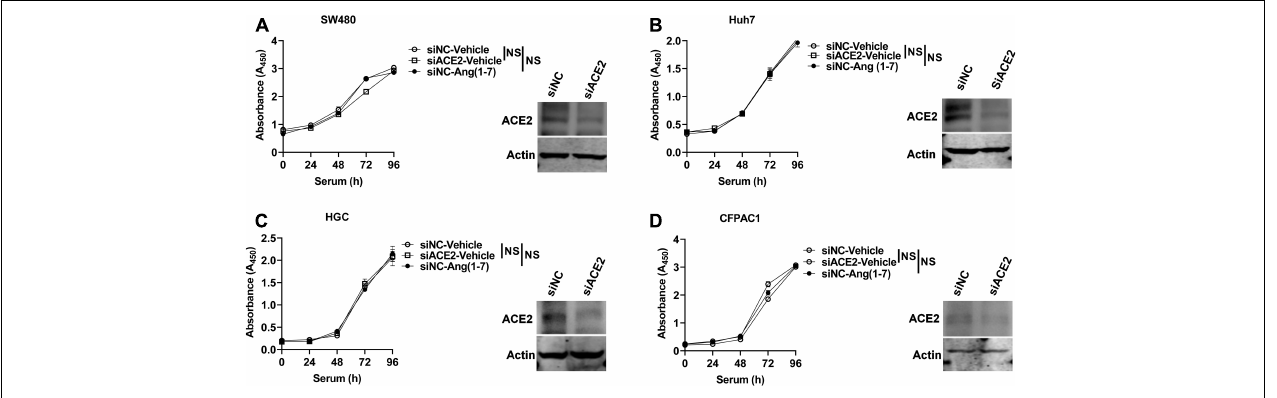
FIGURE 5 | ACE2 does not affect the proliferation of gastrointestinal tumor cell lines. ACE2 was knocked down using siRNA oligos specifically targeted against human ACE2 (siACE2) or negative control (siNC) in gastrointestinal tumor cell lines, and cell proliferation was detected by using the CCK-8 method. (A–D) Proliferation of ACE2 knockdown (siACE2) and negative control (siNC) SW480 (A) , Huh7 (B) , HGC (C) , and CFPAC1 (D) cells stimulated with serum with or without Ang (1–7) for the indicated times. Western blotting confirmed the ACE2 knockdown efficiency in the cells. Data are shown as the mean ± SEM and are representative of three independent replicates. NS, no